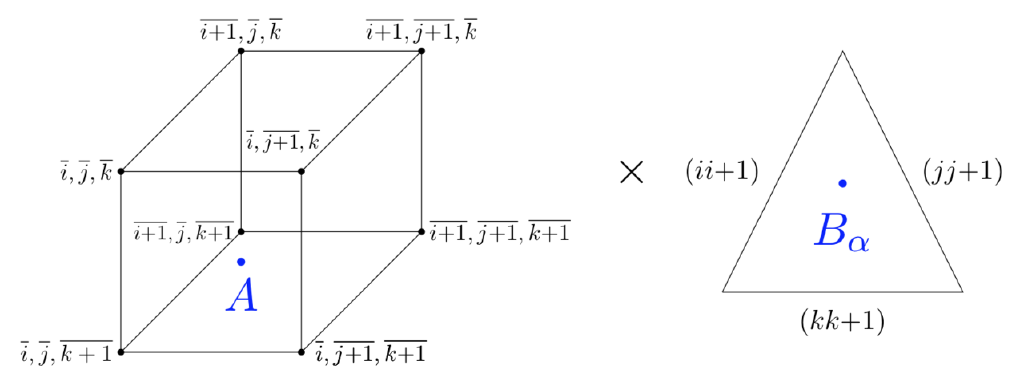
Figure 11 . The geometry of (the geometric dual of) the coplanar cut at n points.